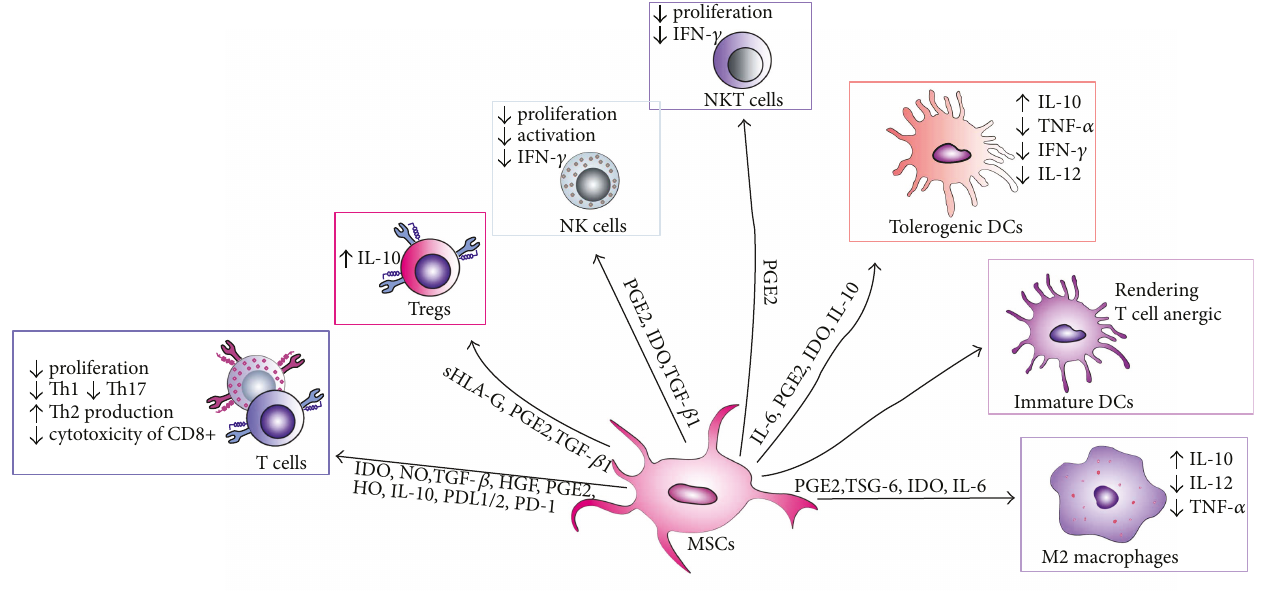
Figure 1: MSC-mediated suppression of immune cells. Through cell-to-cell contact or through producing of soluble factors, MSCs suppress proliferation of e ff ector T cells, attenuate activation and cytokine production in NK and NKT cells, suppress maturation and activation of DCs, and promote the development of anti-in fl ammatory M2 macrophages. MSCs: mesenchymal stem cells; IFN- γ : interferon gamma; TNF α : tumor necrosis factor alpha; DCs: dendritic cell; NK; natural killer; PD-1: programmed cell death protein-1; PD-L1/2: programmed death-ligand 1/2; IDO: indoleamine 2,3-dioxygenase; NO: nitric oxide, TGF- β : transforming growth factor- β ; HGF: hepatocyte growth factor; PGE2: prostaglandin E2; HO: hemeoxygenase; IL-10: interleukin 10; IL-6: interleukin 6; IL-12: interleukin 12; TSG-6: TNF- α -stimulated gene/protein 6; sHLA-G: soluble human leukocyte